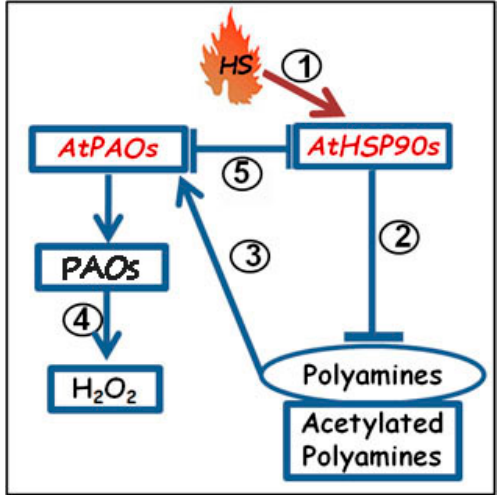
Figure 7. Proposed model of Heat Shock Protein90s (HSP90s)/Polyamine oxidases (PAOs)/Polyamines (PAs)/H 2 O 2 cross-talk in Arabidopsis thaliana : Under conditions of HS, as pivotal HSP stimulator (1), the transgenic/pharmacological reduction of HSP90 genes/HS proteins stimulate an increase of PA and acetylated-PA levels (2), a positive regulation of AtPAO s (3), and further increase of the PAO-related H 2 O 2 (4). Reciprocally, underexpression of AtPAO in Atpao3 mutant reveals stimulation of AtHSP90 transcripts and HSP90 protein levels (5).